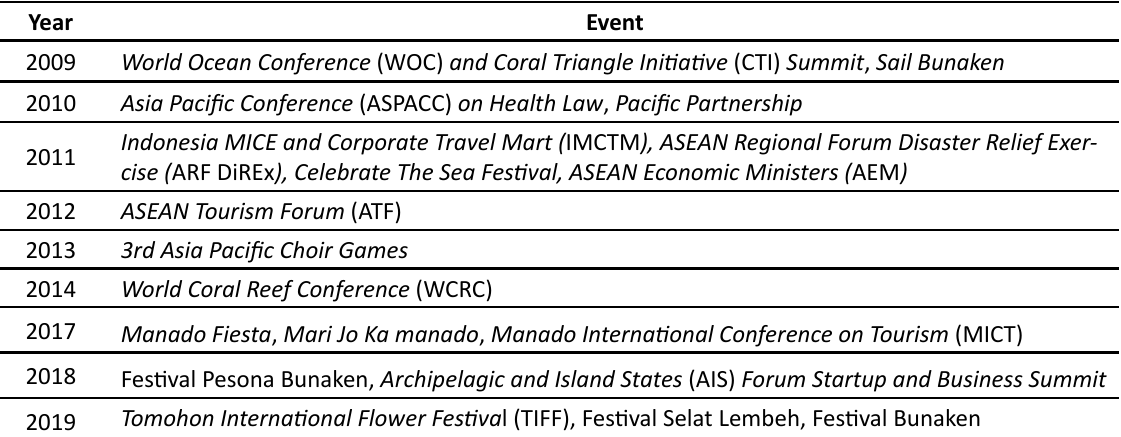
Table 1: International Tourism Event at North Sulawesi, 2009 to